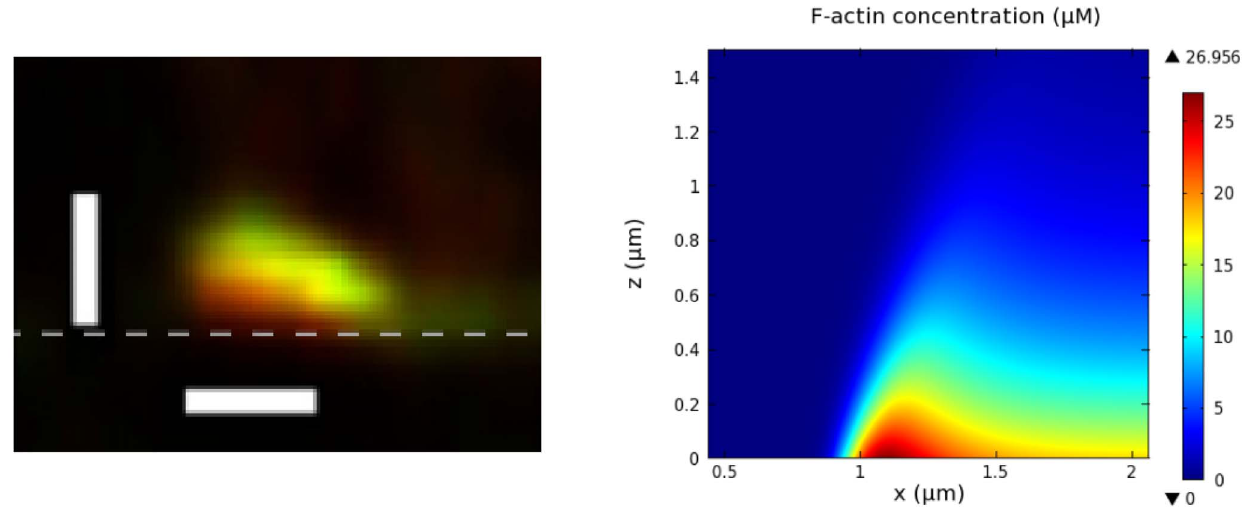
Figure 6. Shape of actin waves. (Left) A z-scan of an actin wave from [21], showing F-actin (red) and coronin (green). The dashed grey line approximates the bottom surface. Bars are 1 m m . (Right) F-actin concentration within a simulated actin